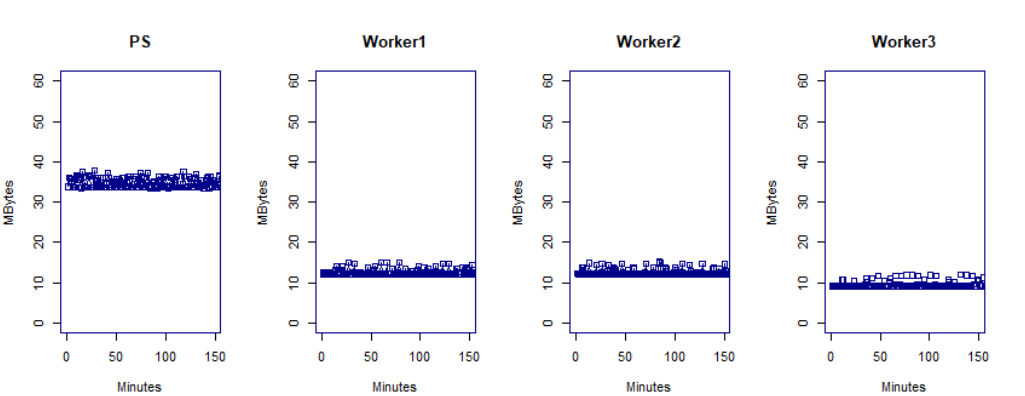
Figure 14. Incoming traffic per worker for the data parallelism